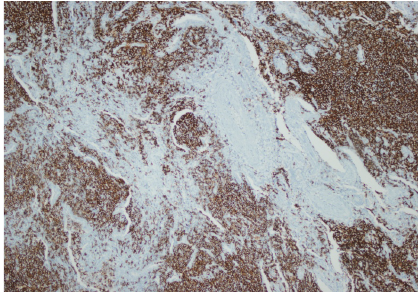
Figure 3: CD20 positive B